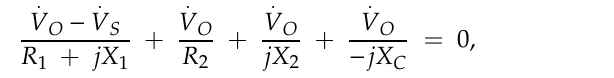
Figure 4. Lumped components model of a distribution line with a load and compensating capacitance with reactance ( X C ). The R 1 and X 1 are resistance and reactance of the distribution line, respectively. The R 2 and X 2 are resistance and reactance of load, respectively. The V S , V 0 , I S , I R 2 , I X 2 , and I C are the source voltage, output voltage, distribution line current, active load current, load reactive current, and capacitor current, respectively.